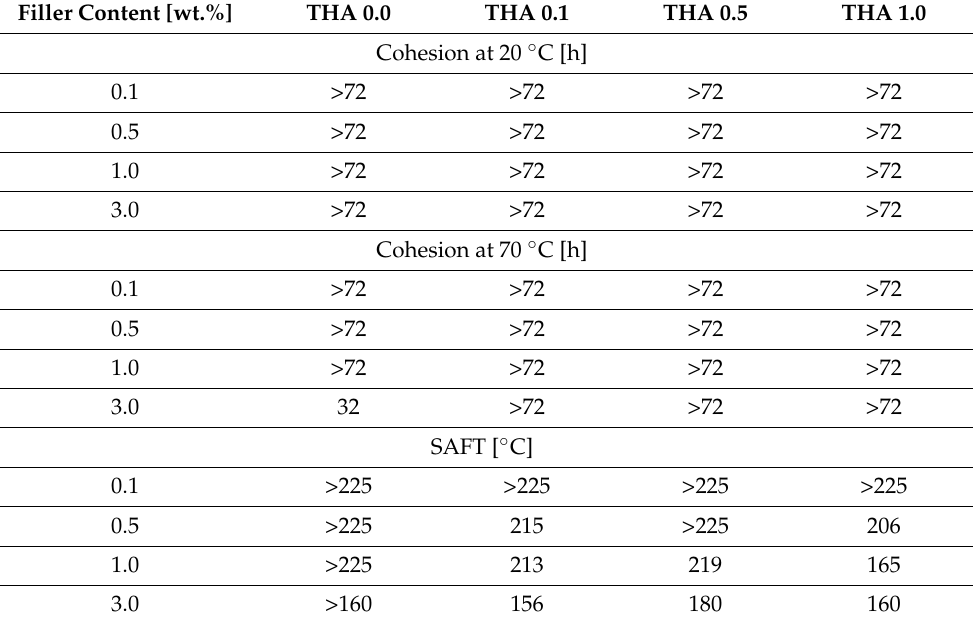
Table 5. Cohesion and thermal resistance prepared silicon Q2-7358 composition with different filler content. Filler Content [wt.%] THA 0.0 THA 0.1 THA 0.5 THA